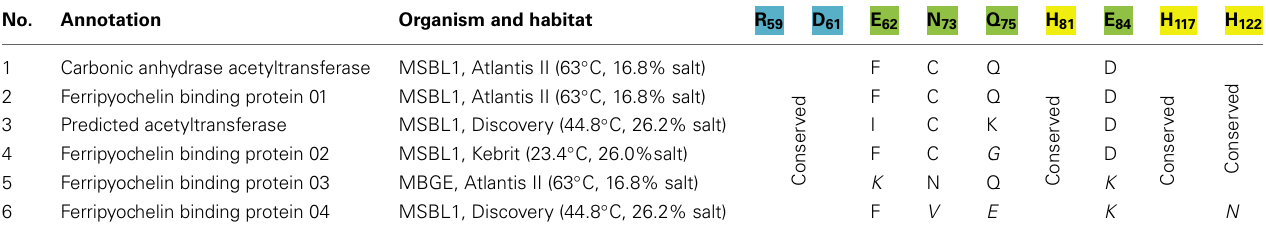
Table 6 | Alignment of functional important residues the γ -CA chain A from Methanosarcina thermophile with γ -CA candidates. No.